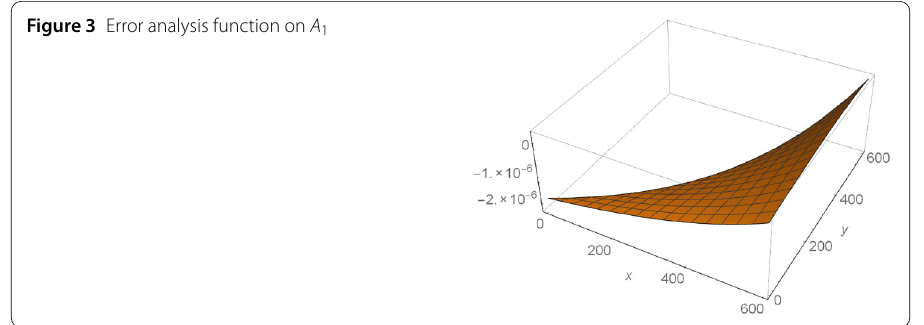
Figure 3 Error analysis function on A